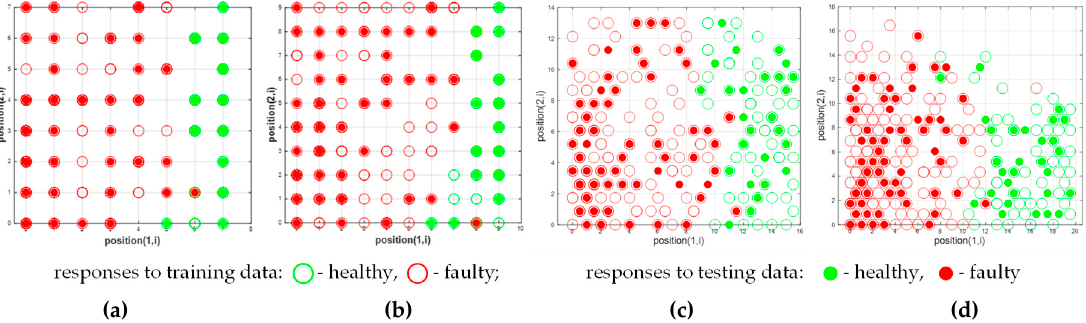
Figure 14. Results of the SOM-based fault detector for the 10 × 10 hexagonal map and the linkdist distance function for different values of the neighbourhood radius: 2 ( a ), 6 ( b ), and for different distance function: linkdist ( c ), dist ( d ) with the neighbourhood radius equal to 2.